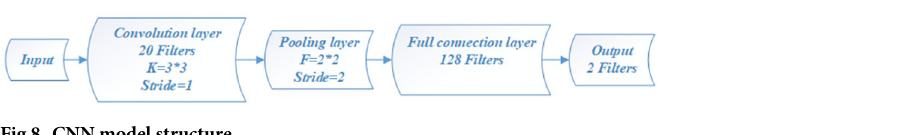
Fig 8. CNN model